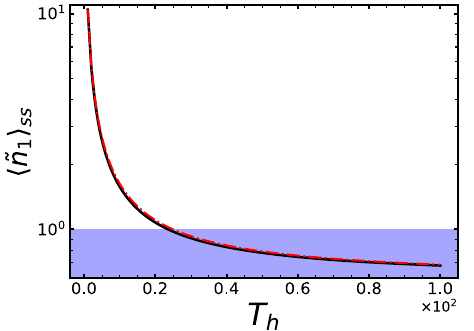
The comparison between the numerical simulation of the master equation given in Eq. (8) and our approximate results is presented in Fig. 3. From Eq. (8), one can obtain the mean number of phonons in the mechanical resonator